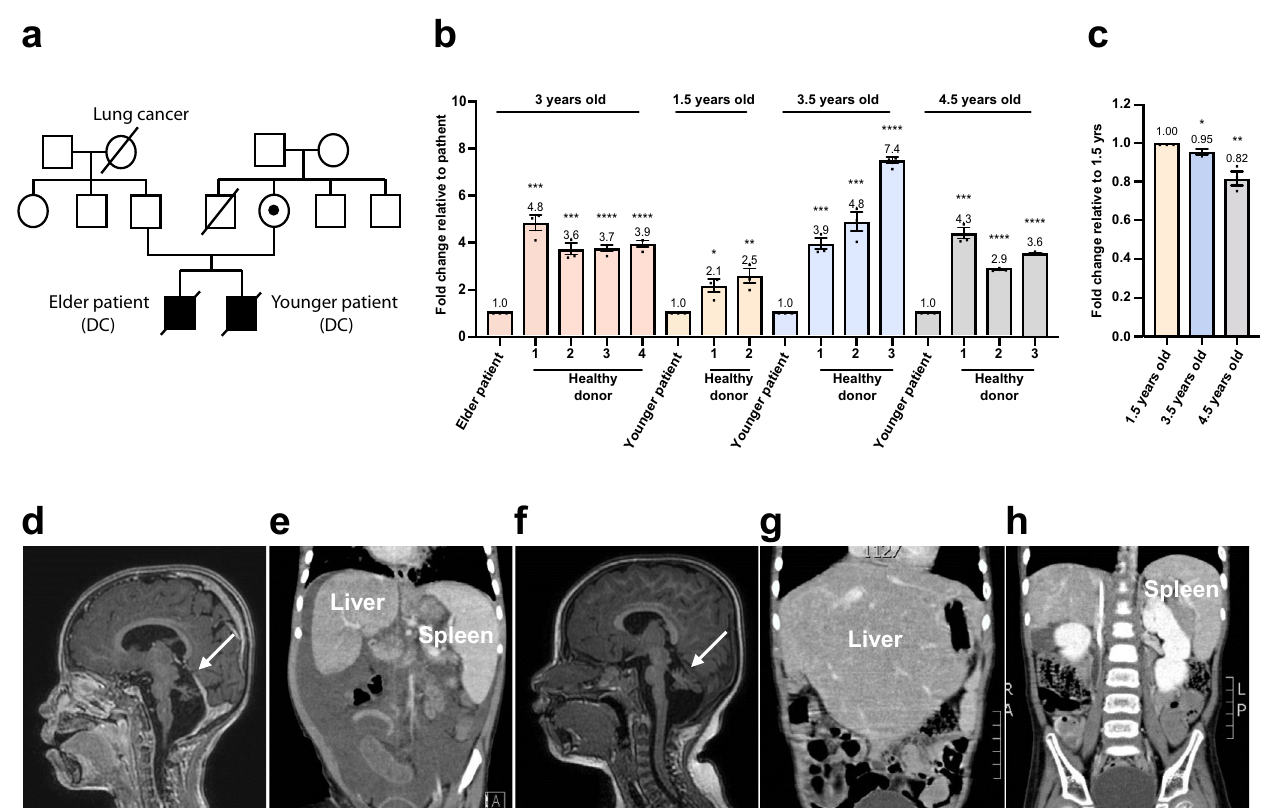
Fig. 1 Clinical phenotype and telomere length measurement. a Pedigree of the family. Unaffected individuals are shown as open shapes. The carrier is shown as a half- fi lled shape. Clinically affected individuals are shown as fi lled shapes. A deceased individual is shown as a shape with a diagonal line. Squares represent males. Circles represent females. b Telomere length measurement by quantitative PCR (qPCR) of peripheral blood cell genomic DNA from patients in the family and age-matched controls. Autosomal single copy gene ( 36B4 ) served as the basis for normalizing the telomere quantitative PCR signal. Bar graph of mean fold change for telomere length of age-matched samples relative to patients. Mean values were calculated from triplicate qRT-PCR experiments of three technical replicates, with bars representing SE. c Telomere length measurement by quantitative PCR (qPCR) of peripheral blood cell genomic DNA from the younger patient in the family. Autosomal single copy gene ( 36B4 ) served as the basis for normalizing the telomere quantitative PCR signal. Bar graph of mean fold change for telomere length of samples as indicated age relative to the sample from 1.5 years old. Mean values were calculated from triplicate qRT-PCR experiments of three technical replicates, with bars representing standard error of the mean (s.e.m.). Brain MRI showing cerebellar hypoplasia in the elder patient at 2.5 years old ( d ) and the younger patient at 1 year old ( f ). An abdominal computed tomography scan revealed hepatosplenomegaly in the elder brother at 1.3 years old ( e ) and in the younger brother at 3 years old ( g and h